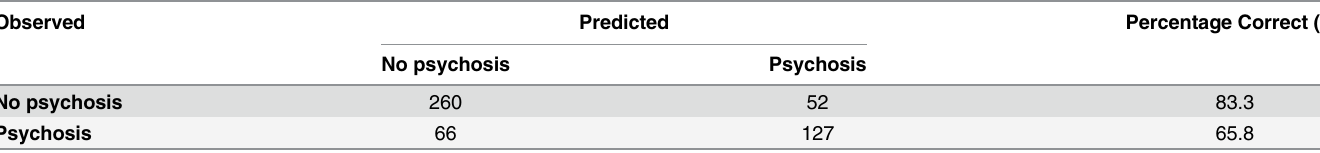
Table 5. Classification